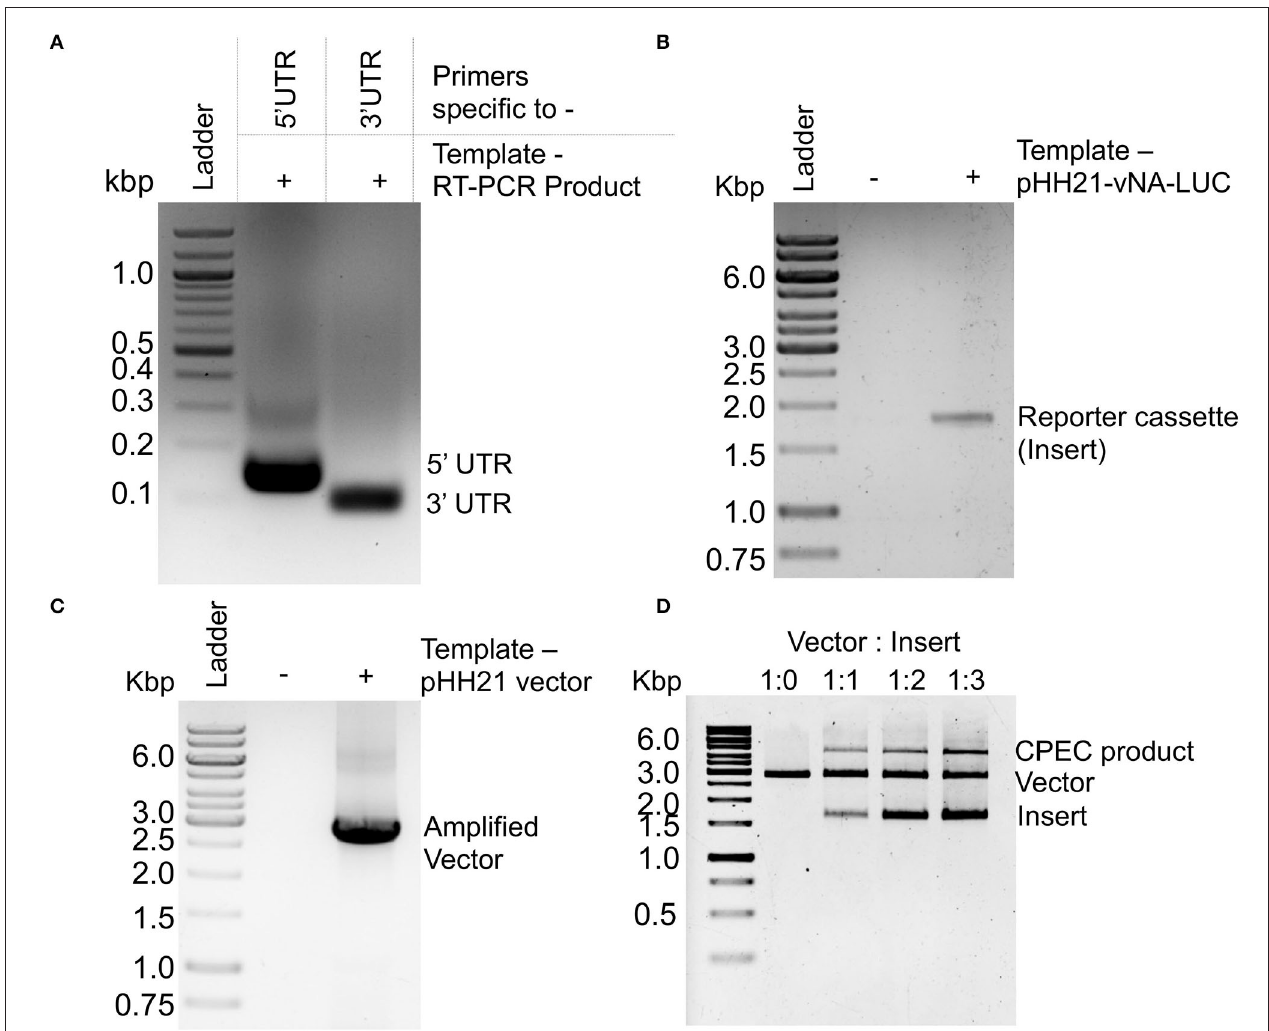
FIGURE 2 | PCR amplification and CPEC reaction for the construction of a reporter construct: Agarose gel electrophoresis images of (A) PCR amplification products corresponding to the 5 ′ and 3 ′ UTRs of NA-NB segment. (B) PCR amplification product of the luciferase ORF using double-stranded PCR products corresponding to 5 ′ and 3 ′ UTRs as primers. (C) PCR amplification of the pHH21 vector. (D) CPEC products with different ratio of vector and insert.